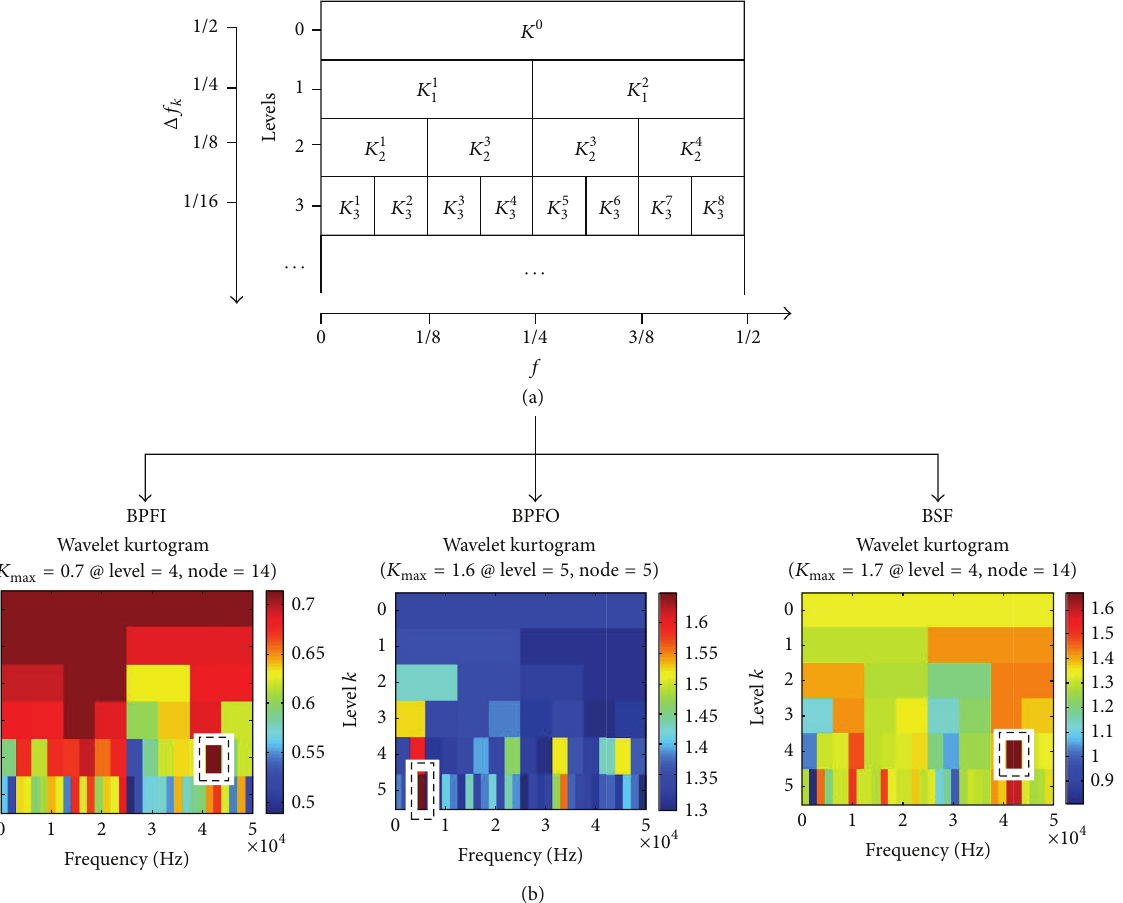
Figure 3: The proposed wavelet kurtogram. (a) The frequency-scale paving of the proposed wavelet kurtogram. (b) An example of a proposed wavelet